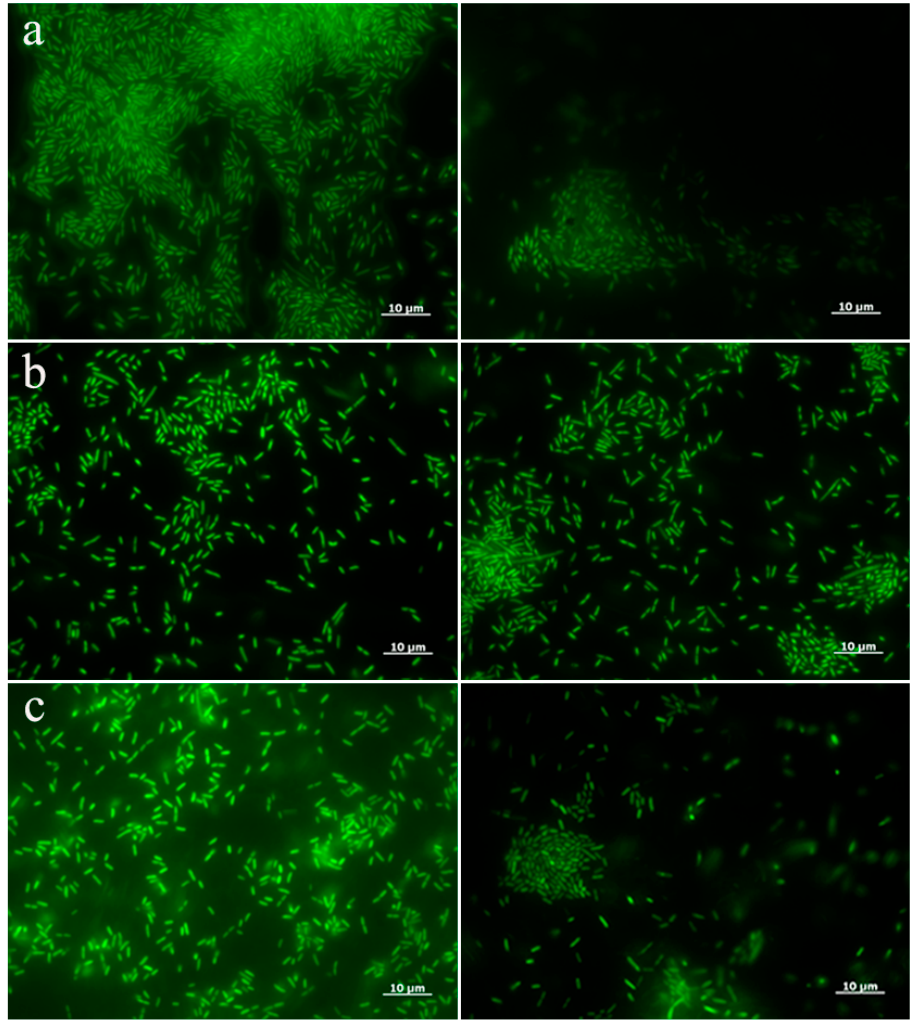
Figure 2. LIVE/DEAD staining after treatment with ZnO-NRs. Fluorescence microscope images of untreated bacterial strains (left) and treated cells with a concentration of ZnO-NRs of 125 µg/mL (right). ( a – c ) indicate respectively A. aurescens TC4, A. spanius TC1, and A. spanius